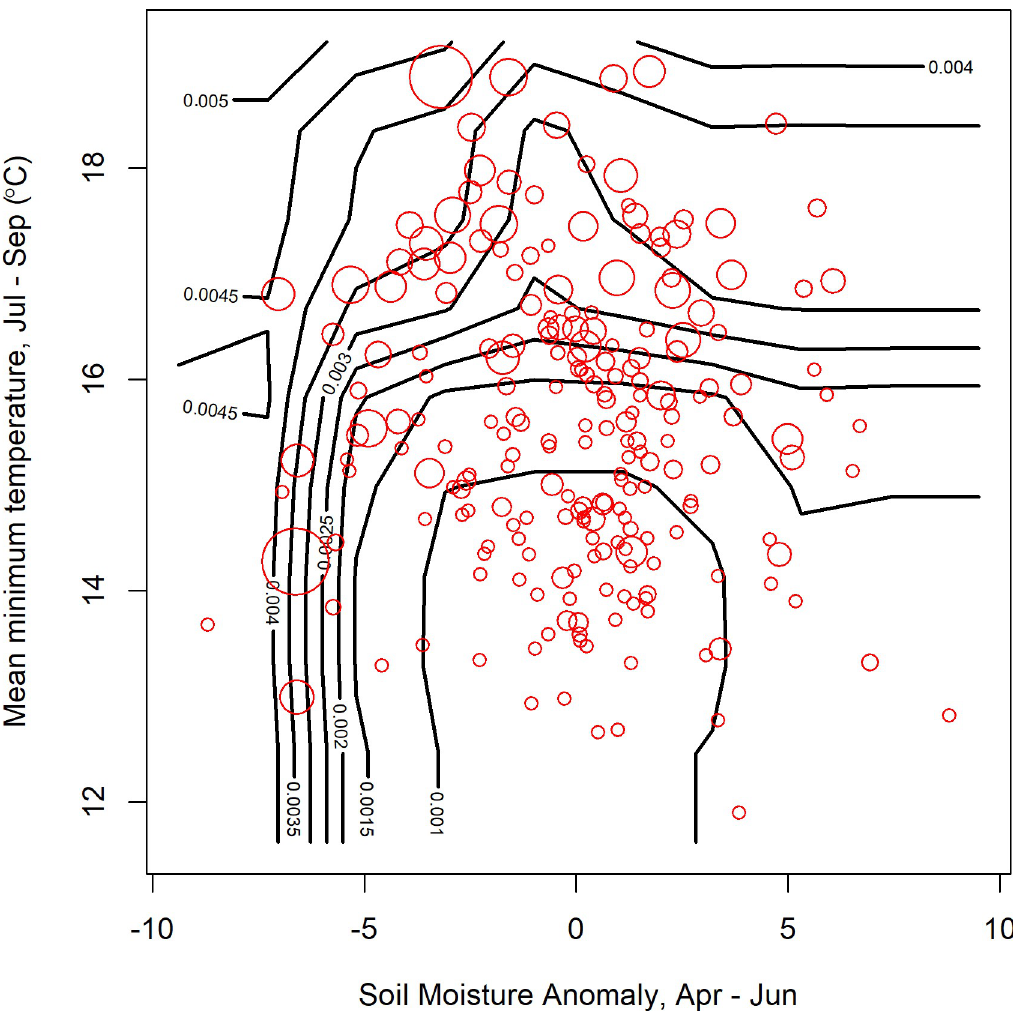
Fig 6. Predicted mosquito infection rates ( MLE , contours) increase non-linearly with 2 nd quarter soil moisture anomaly and 3 rd quarter temperature. Cool years with normal soil moisture were associated with the lowest MLE . Warm years showed high MLE regardless of soil moisture and dry years often (but not always) had high MLE . Observations (red circles, size is proportional to MLE ) broadly support these predictions. Contour lines correspond to predictions made for a regular grid of 100 points covering the range of both variables. Predictions were made for mean values for all other covariates (see Tables 4 and 5 for included variables, see S1 File for mean values), while observed values correspond to the exact variable combinations and therefore may not exactly correspond to the predictions. Observations are plotted as a general guide to identify major patterns and highlight particular